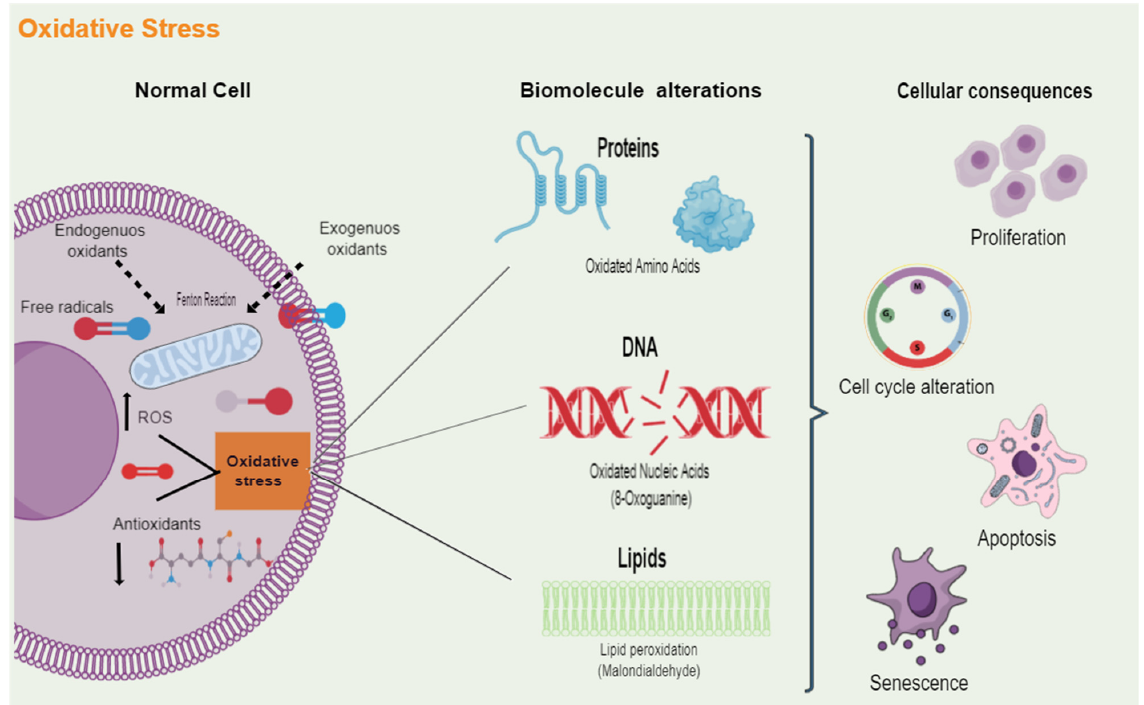
Figure 1. Cellular damage induced by oxidative stress. Multiple endogenous and exogenous sources produce free radicals, which are molecules that contain one or more unpaired electrons. When an imbalance arises between the oxidative molecules present in cells, such as reactive oxygen species (ROS), and the antioxidant defenses that neutralize and eliminate these reactive radicals, oxidative stress is generated. Excess oxidative stress can play a dominant role in protein, cell membrane phospholipids, and DNA damage. The attack of ROS on these biomolecules alters their functions and, ultimately, will lead to the dysregulation of different cellular processes, including proliferation, cell cycle, cell death, and senescence.